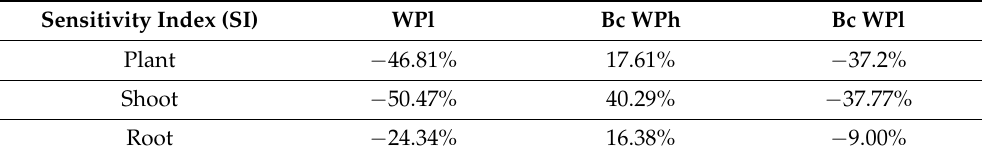
Table 1. Relative impact (SI in %) of drought and biochar on the dry weight of Medicago ciliaris plant, shoot and root. Low soil water potential (WPl), high soil water potential (WPh), Biochar (Bc).